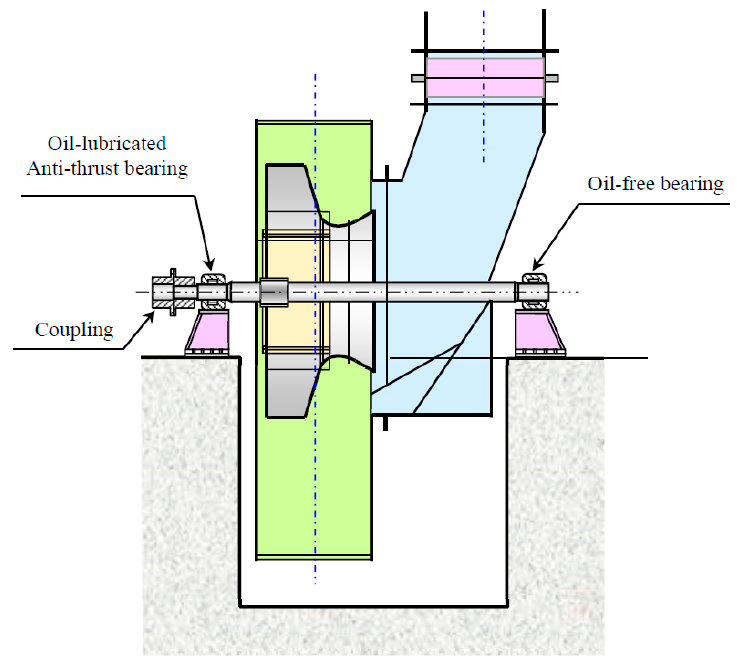
Figure 19. Detailed schematic diagram of the booster fan and its key component, the centrifugal compressor.